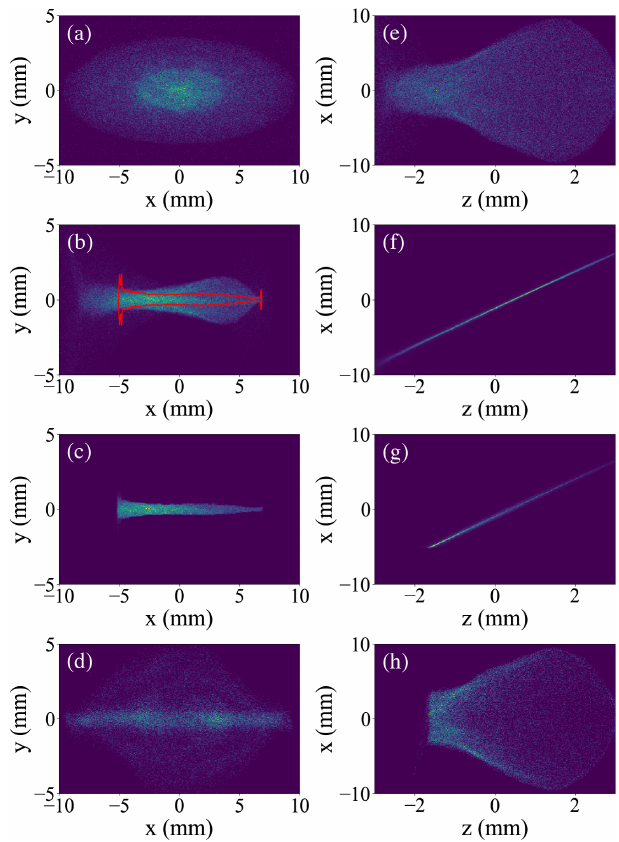
FIG. 12. Beam images on the x − y and z − x plane. Each row corresponds to a location along the shaping system. (a) and (e) are the images at the entrance of the shaping system. (b) and (f) are the images at the entrance of the mask. The red curve in (b) is the shape of the mask used for the simulation. A particle sitting inside the mask area passes through the mask, while other particles are stopped by the mask. (c) and (g) are the images at the exit of the mask. (d) and (h) are the images at the exit of the shaping system. These images are simulation results for the doorstep profile given in Sec. III.